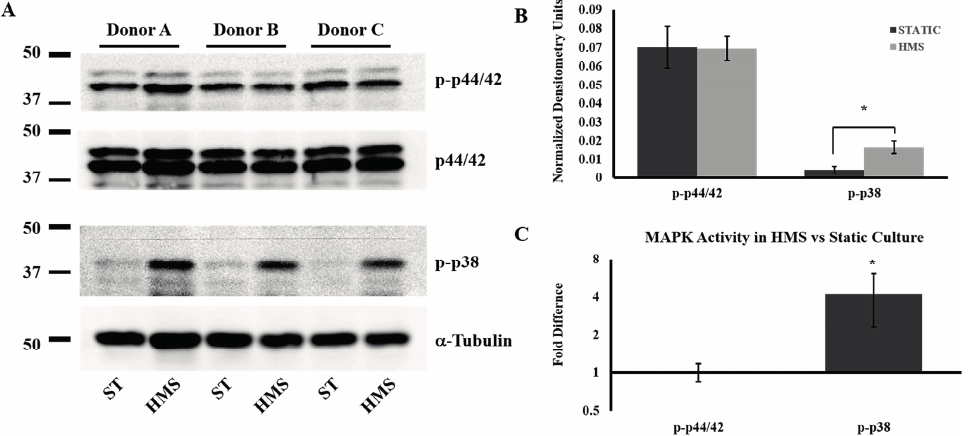
Figure 3. Western blot analysis. ( A ) Images acquired from immunoblots probing cell lysates from 3 donor animals (Donor A–C) probing for phosphorylated p44/42 (ERK), total p44/42 (ERK), phosphorylated p38, and for α -tubulin as a loading control; ( B ) Densitometry analysis of pERK normalized to total ERK and p-p38 normalized to α -tubulin; ( C ) Mean fold-difference in high mechanical strain (HMS) induced p-ERK and p-p38 activity versus static culture chondrocyte controls. Error bars: ±SEM, n = 3. Student’s t -test. * indicates p < 0.05. ST, static; HMS, high mechanical strain.